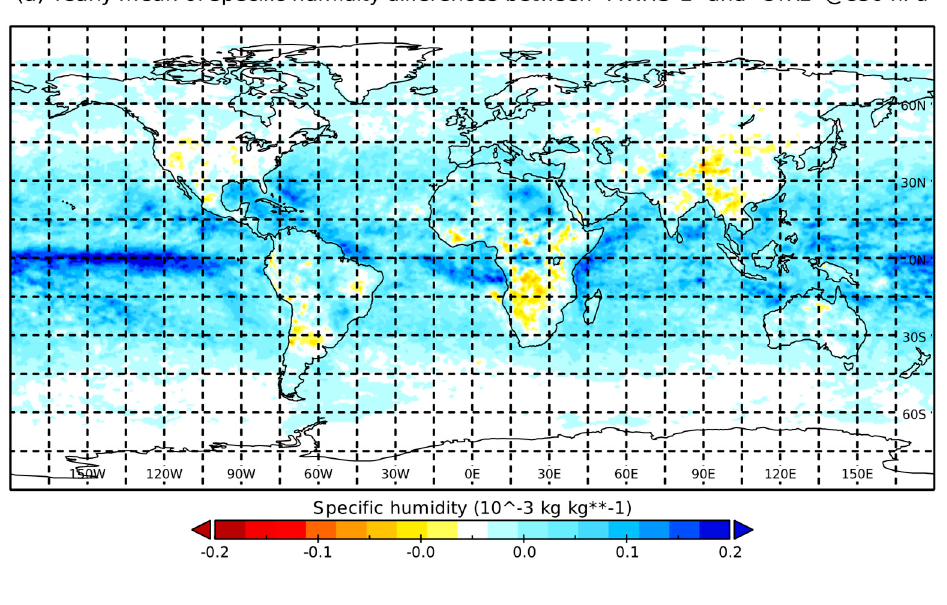
10 of 16 Figure 4. Zonal ‐ mean cross ‐ section of yearly mean (from August 1, 2016 to August 31, 2017) specific humidity analysis for the “MWHS ‐ 2” experiment ( a ) and (ERA5) ( b ) and the differences between “CTRL” and ERA5 ( c ) and also the differences between “MWHS ‐ 2” and “CTRL” ( d ).